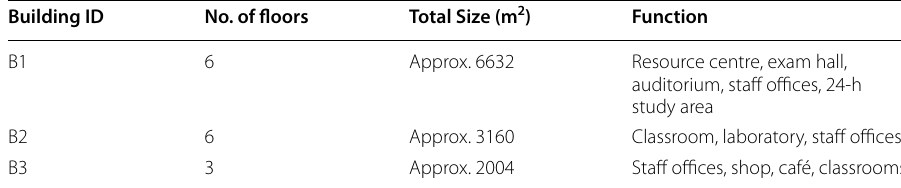
Table 1 Malaysian building complex description